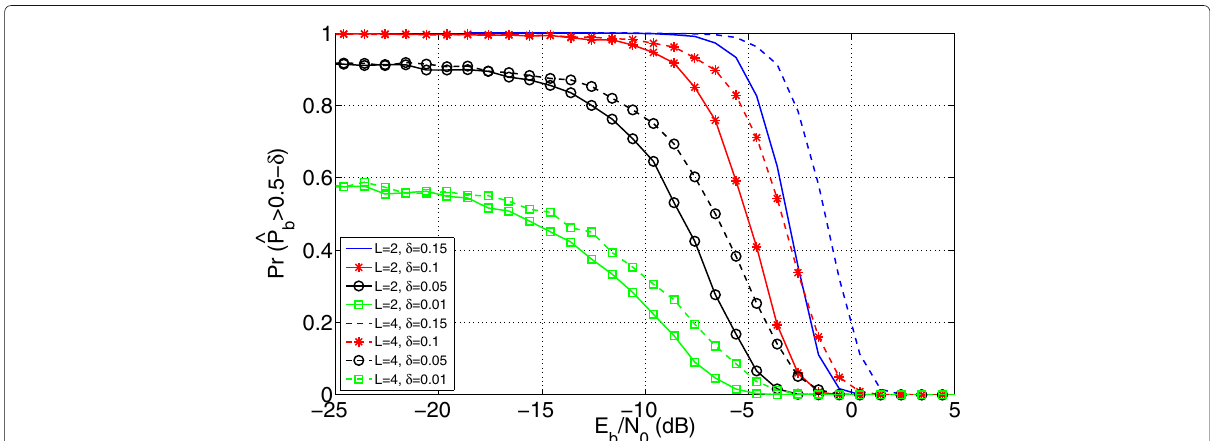
(cid:2) (cid:3) ˆ P > 0.5 − δ for the BCH(127,92) code for S b = 2 × 92 = 184 using L -order DPSK modulation. b